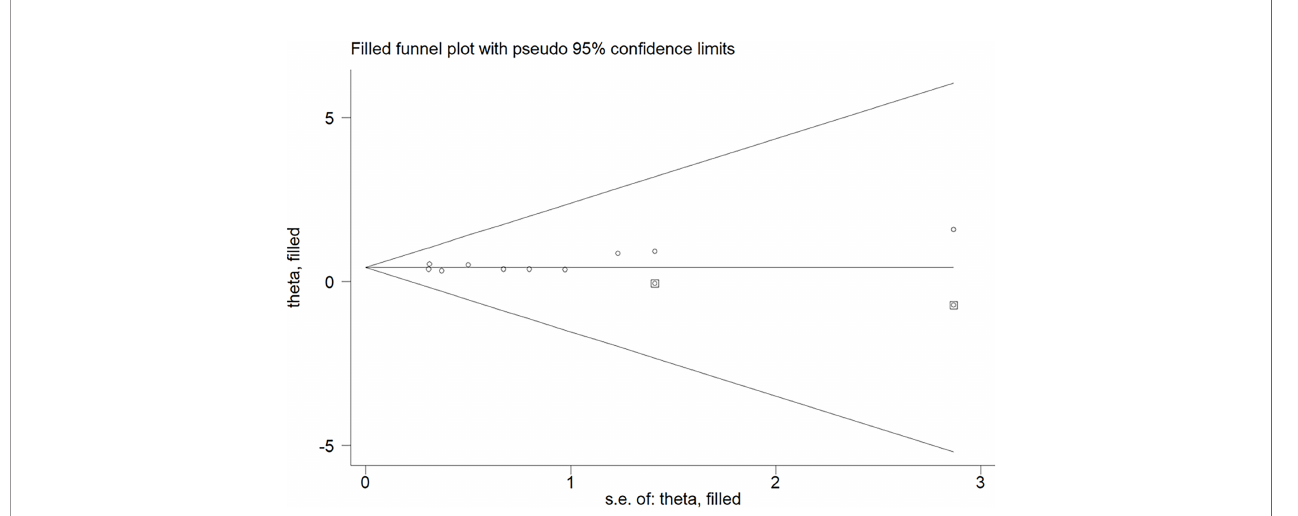
FIGURE 3 | Funnel plot showing the impact of a lower prealbumin level on overall survival. The circles alone are real studies; circles enclosed in boxes are “ fi lled ”